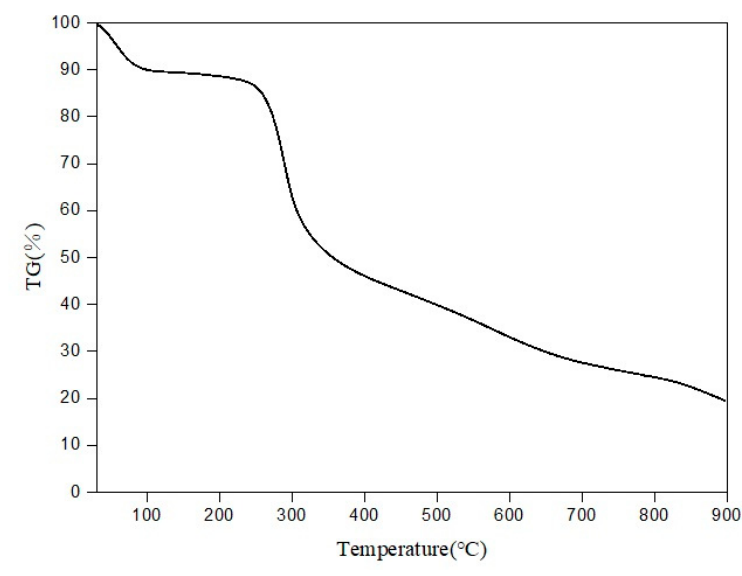
Figure 4. Thermogravimetry (TG) curve of chitosan fiber.